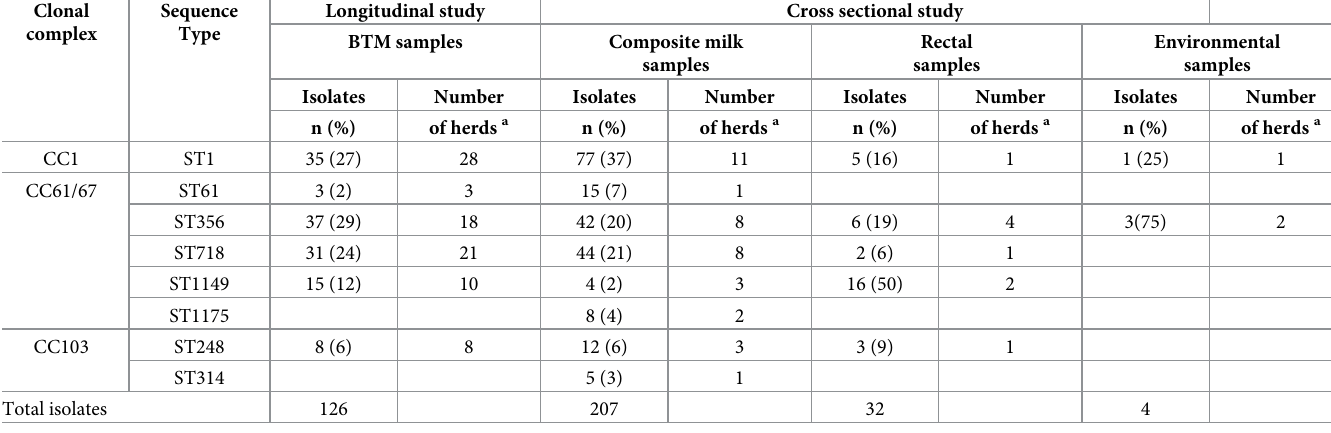
Table 4. Frequency of detection of Streptococcus agalactiae clonal complexes (CC) and sequence types (ST)in bulk tank milk (BTM) and cow-level samples from dairy herds in central western Colombia. Clonal complex